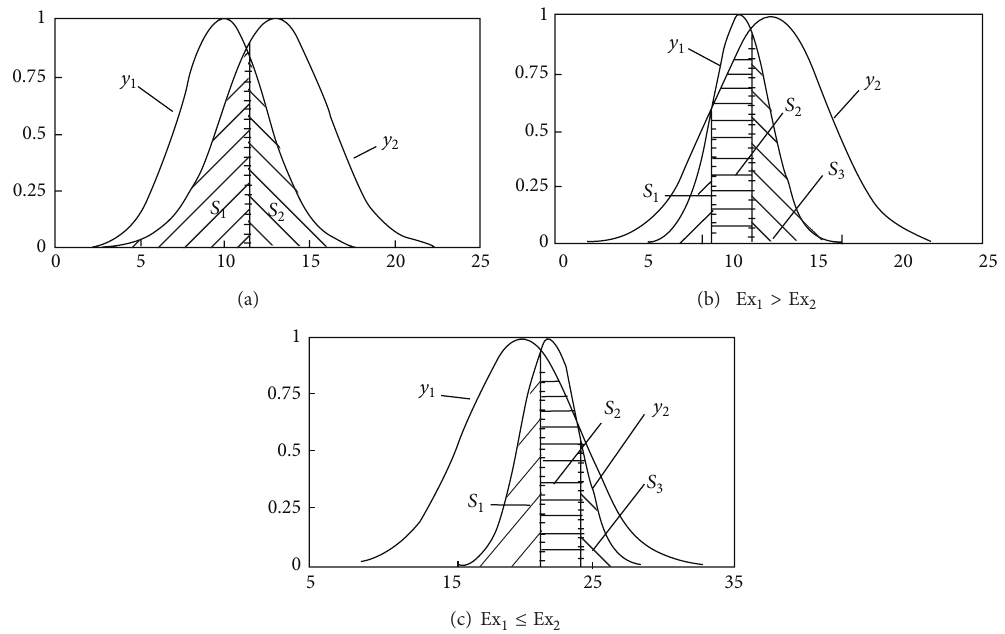
Figure 1: Similar situation between normal